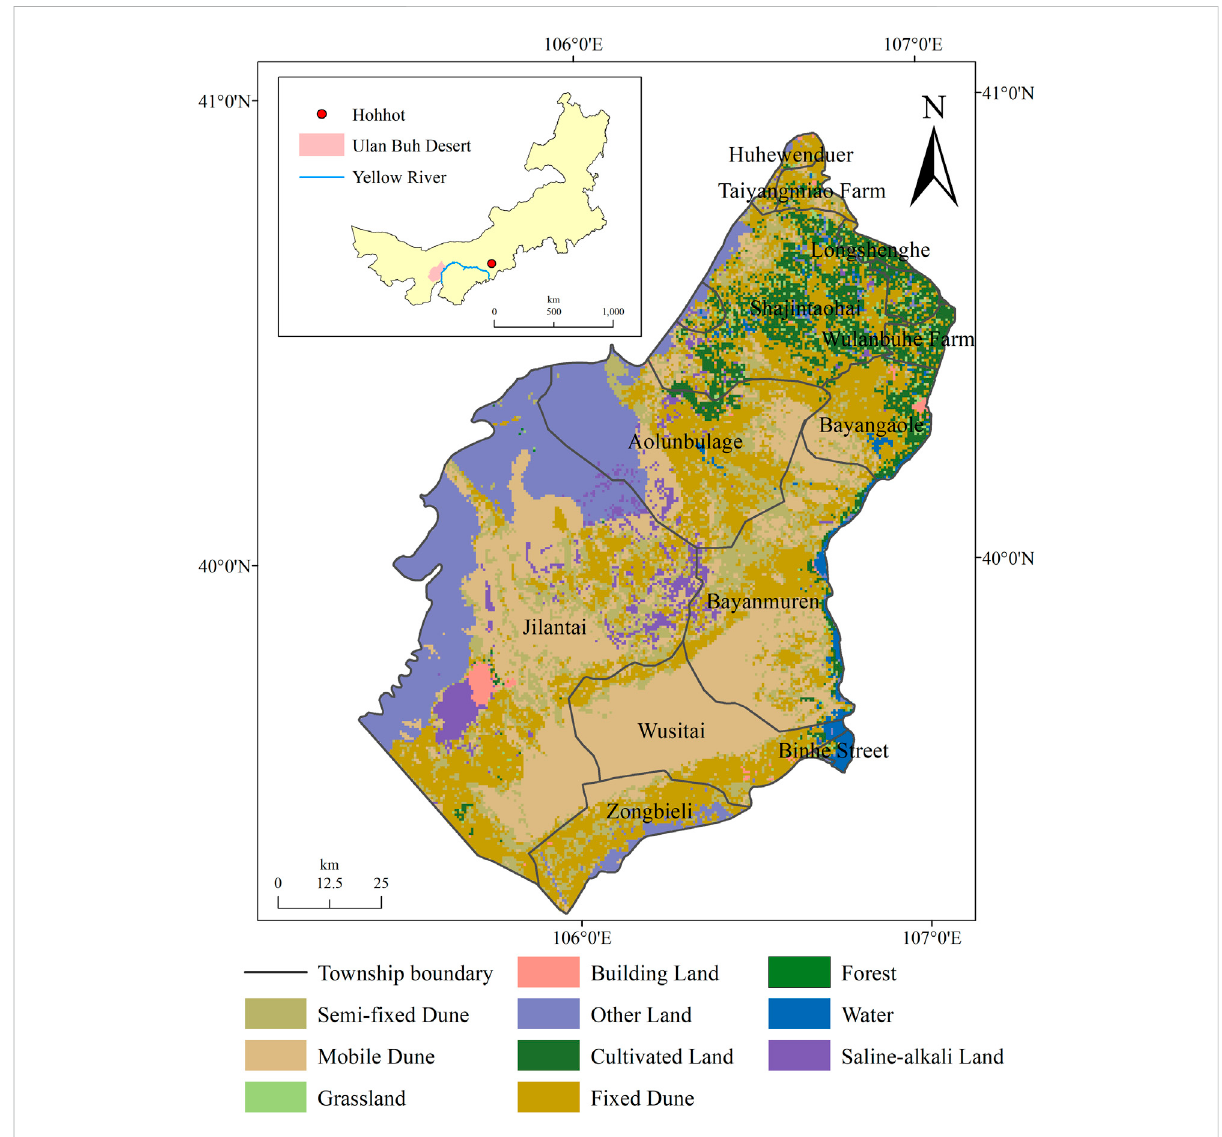
FIGURE 1 Location of the study area (land use type data are from